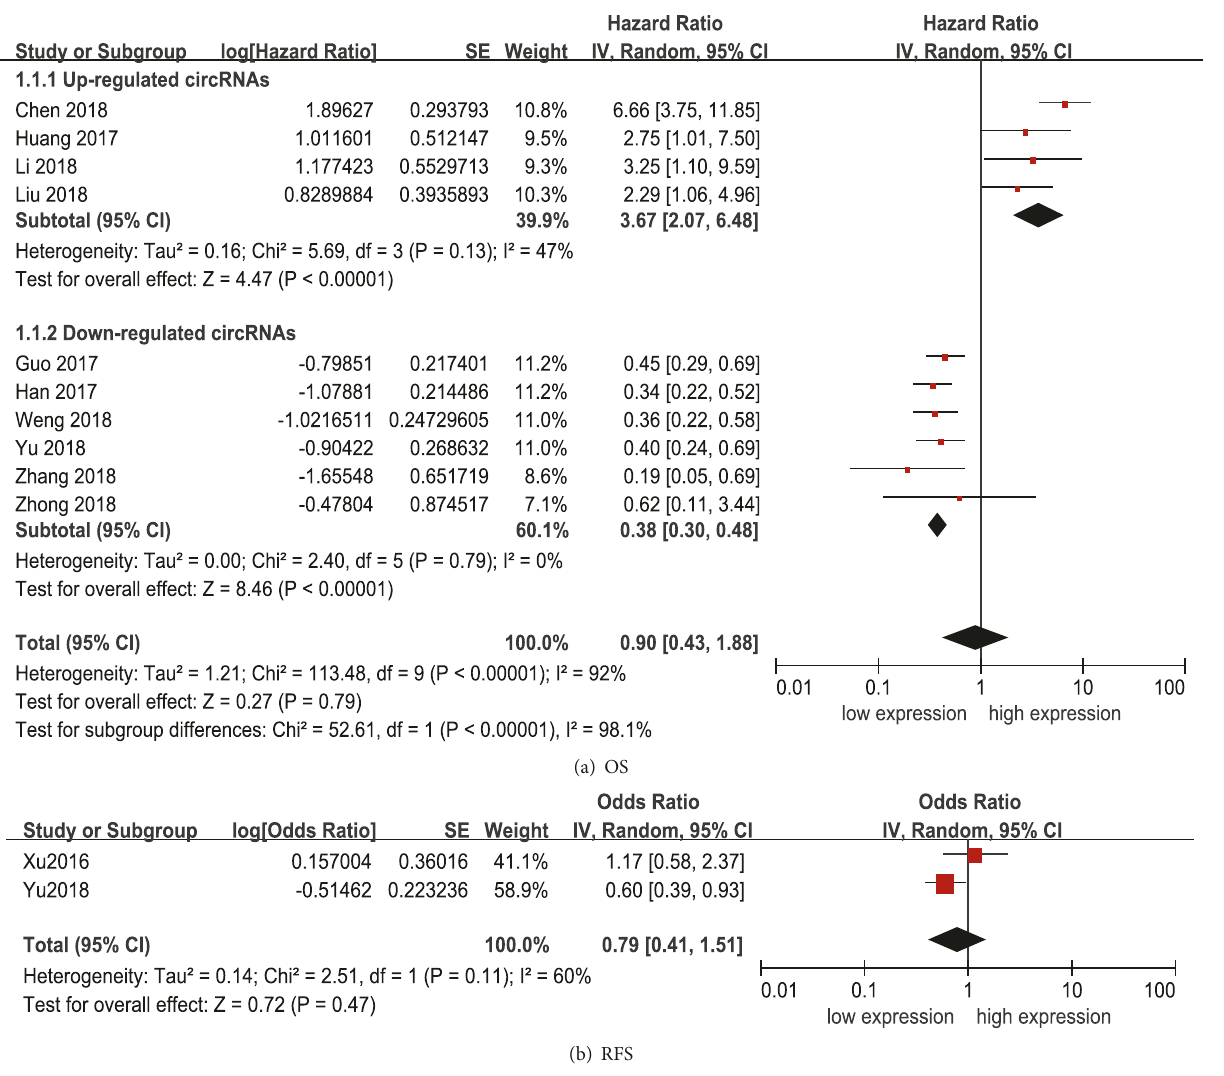
Begg’s funnel plot with pseudo 95% confidence limits